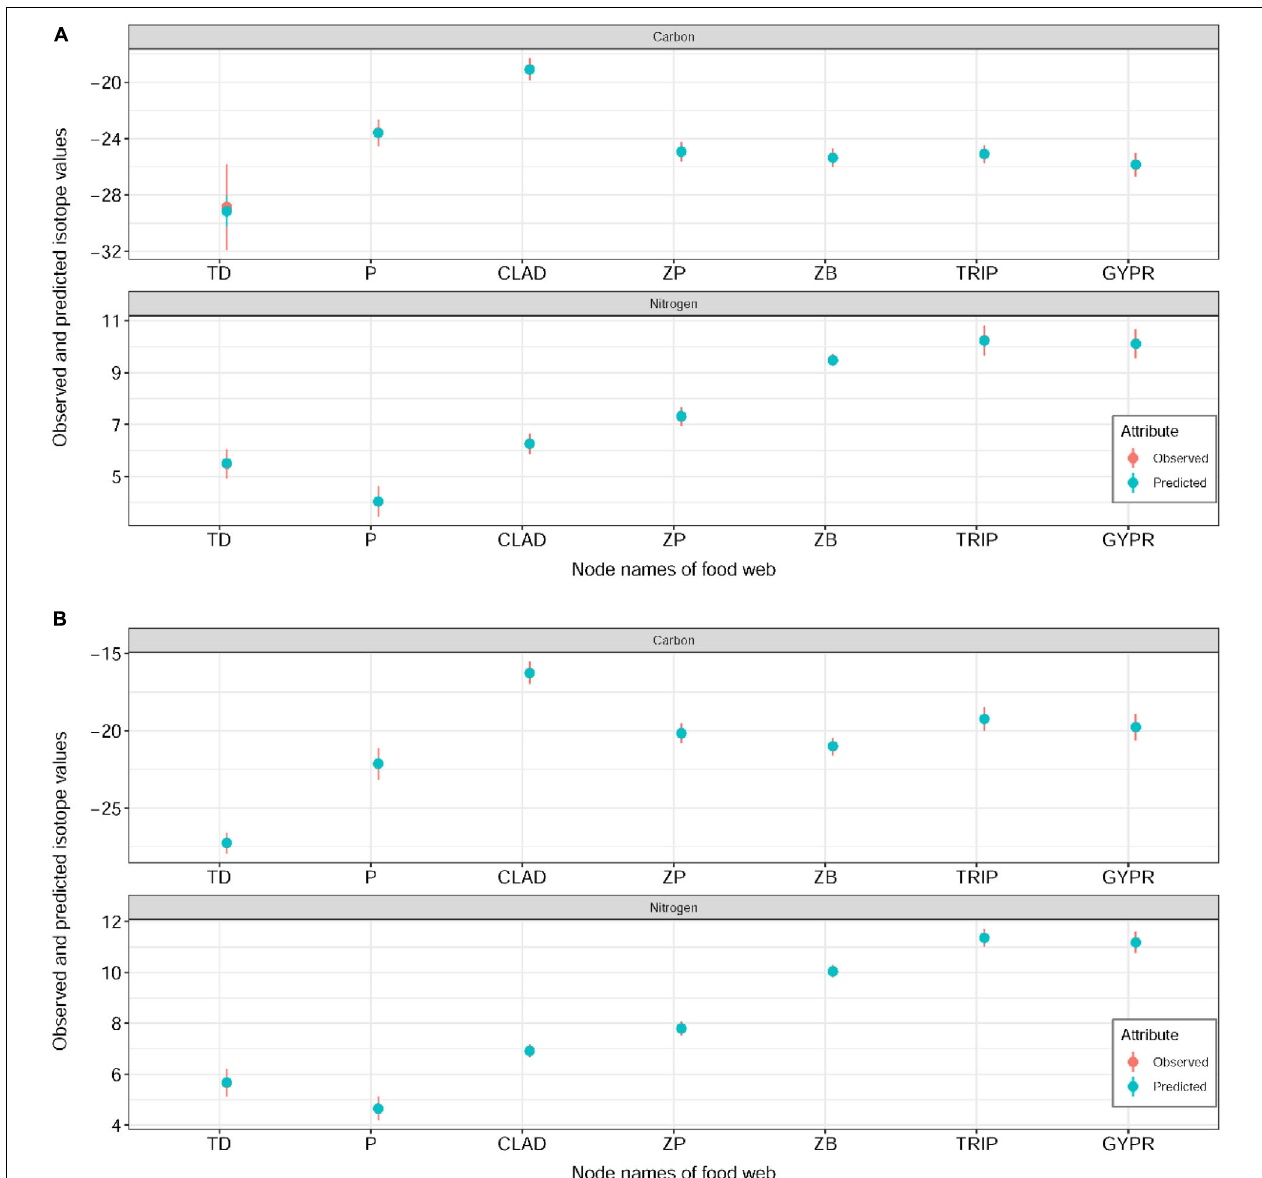
FIGURE 3 | Comparison of model predictions (blue) and observations (red) in original (A) and new (B) habitats. The solid points show the medians of observed and predicted values, whereas error bars represent 95% confidence intervals for each